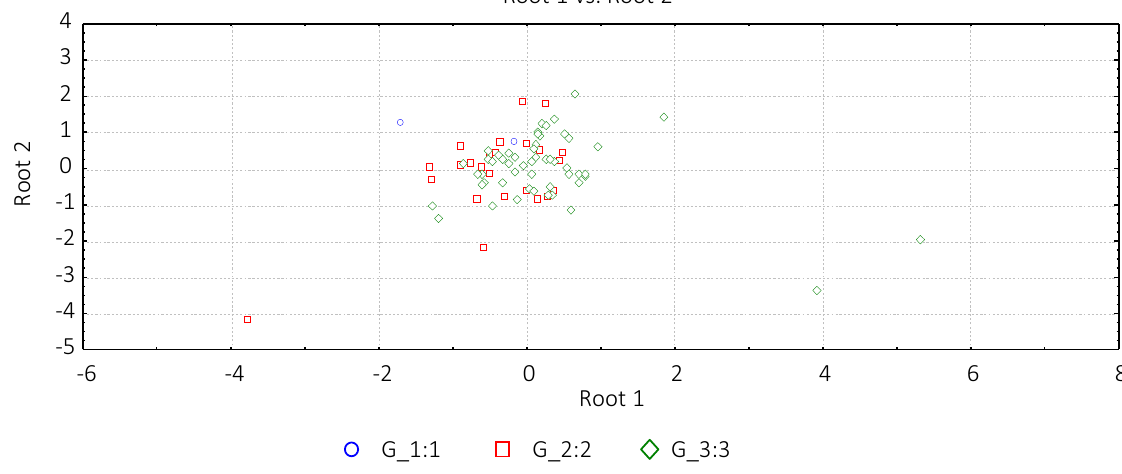
Figure 2. The results of grouping countries by the level of economic growth